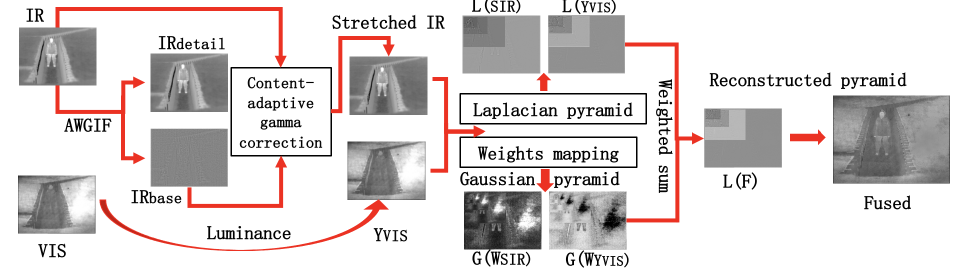
Figure 1. Proposed